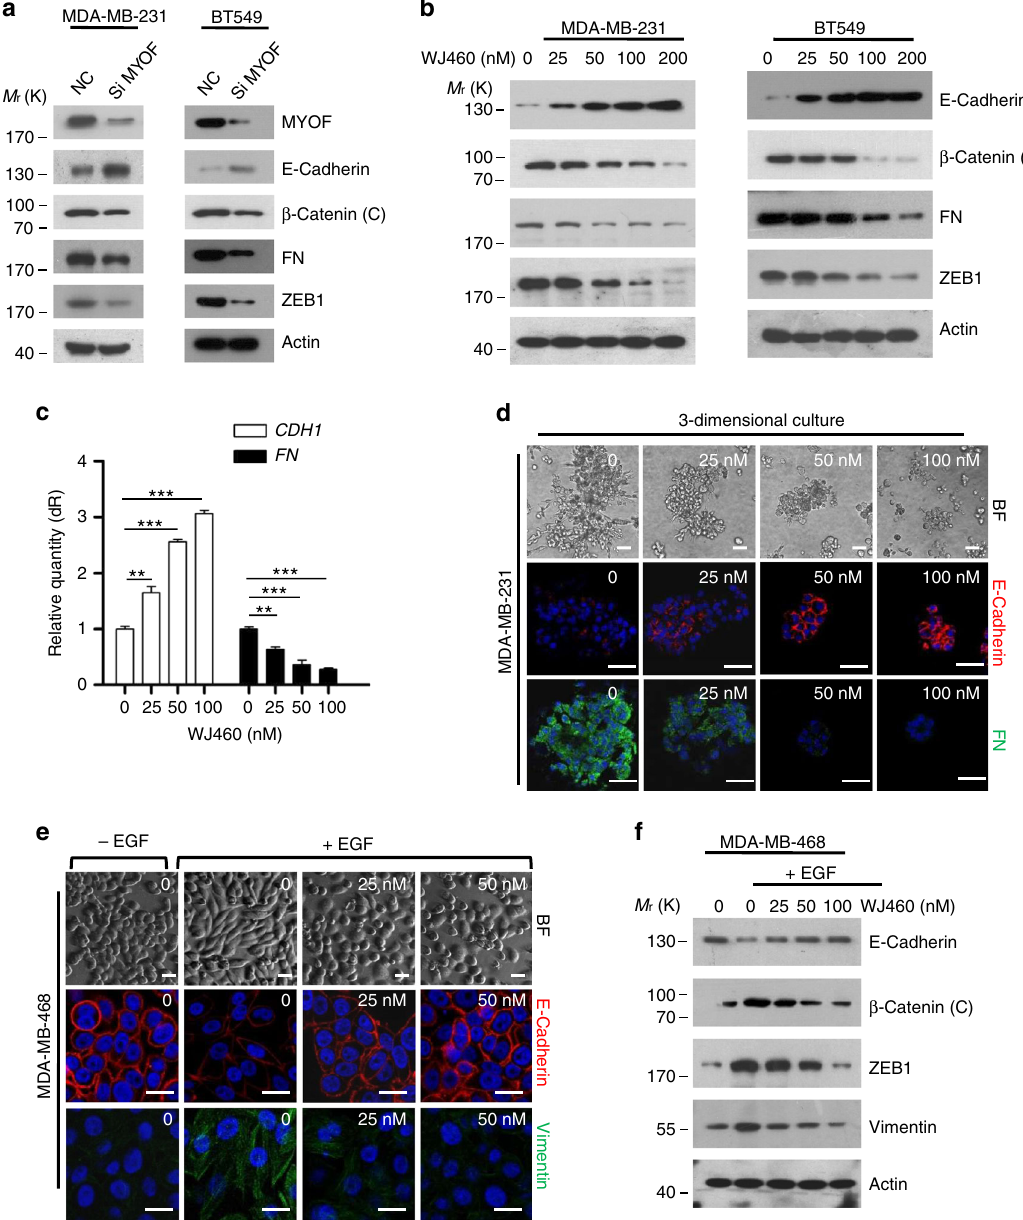
Fig. 6 WJ460 reverses EMT in breast cancer cells. a MYOF ablation in the indicated breast cancer cells increased the expression of epithelial marker E- cadherin (Cytosolic extracts), whereas mesenchymal markers cytosolic β -catenin, fi bronectin and ZEB1 were downregulated ( n = 3). b Western blot analysis of EMT markers after WJ460 treatment ( n = 3). c Quantitative RT-PCR analysis of EMT markers after WJ460 treatment ( n = 3). Data shown are mean ± s.d. ** p < 0.01, *** p < 0.001. d MDA-MB-231 cells were seeded on a layer of Matrigel. Growth medium containing 10% Matrigel and different concentrations of WJ460 was added on top of the cells. After 4 days, cells were extracted by PBS-EDTA and replated onto coverlips. Cells were then fi xed and stained for E-cadherin (red) and fi bronectin (green) ( n = 3). Scale bars, 50 μ m. e MDA-MB-468 cells were treated with WJ460 and EGF or not. Four days after treatment, cells were stained for E-cadherin (red) and Vimentin (green) ( n = 3). Scale bars, 20 μ m. f Western blot analysis of MDA-MB-468 cells undergoing EGF-induced EMT ( n = 3). In each panel, n indicates the number of independent experiments suggested that a high MYOF level is associated with increased aggressiveness of breast cancer. WJ460 reverses EMT in breast cancer cells . Derailed endocytosis results in several hallmarks of cancer including enhanced inva- siveness and EMT 24 . EMT endows cancer cells with an invasive phenotype and EMT is also essential in other stages of tumor metastasis 25 . WJ460 binds to MYOF to repress its role in